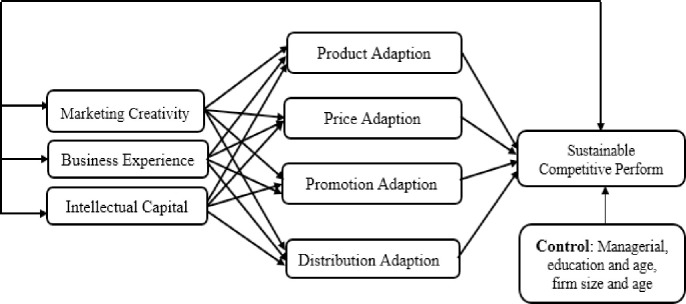
Hypothesized model.